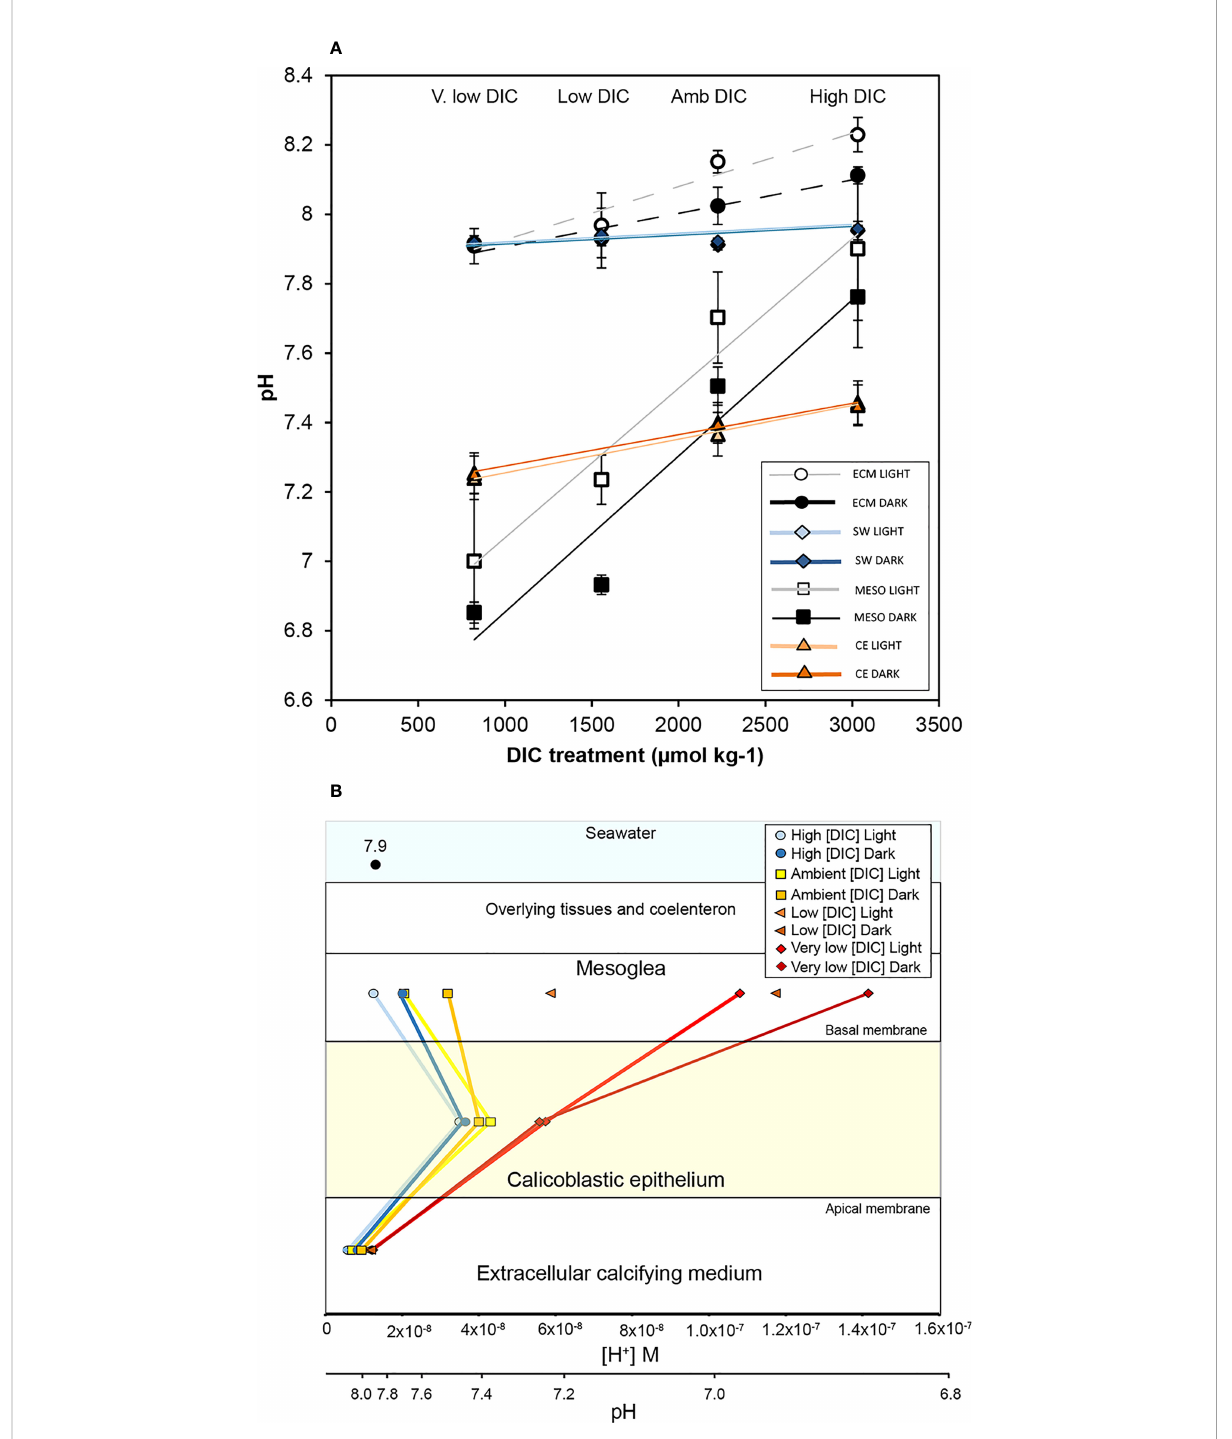
FIGURE 3 The in fl uence of seawater dissolved inorganic carbon concentration [DIC] and in light and darkness on the pH gradient across the calcifying epithelium of S. pistillata . (A) pH (means ± SD) in the mesoglea (MESO), seawater surrounding the corals in the perfusion chamber (SW), the extracellular calcifying medium (ECM) and the calicoblastic epithelium (CE). ECM and CE values taken from (Comeau et al., 2017). A linear regression is drawn for each data set to display the trend. (B) Mean pH values from panel (A) plotted on parallel [H + ] and pH scales to illustrate the proton gradient across the CE. The pH level of seawater (pH 7.9) is indicated in the seawater compartment. Low [DIC] treatment pHi values in the CE are not shown as they were not measured in Comeau et al.